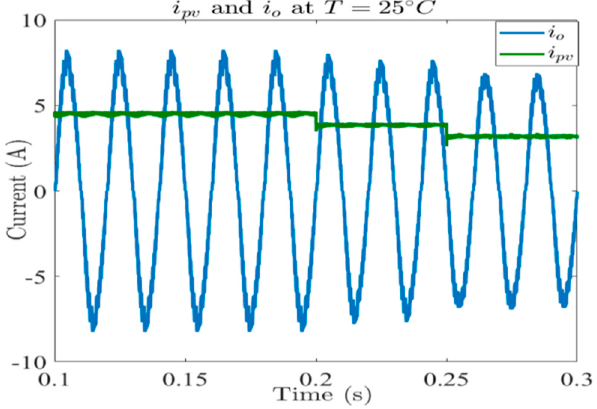
Figure 11. The simulation results of 𝑖 (cid:3043)(cid:3049) and 𝑖 (cid:3039)(cid:3042)(cid:3028)(cid:3031) under changing